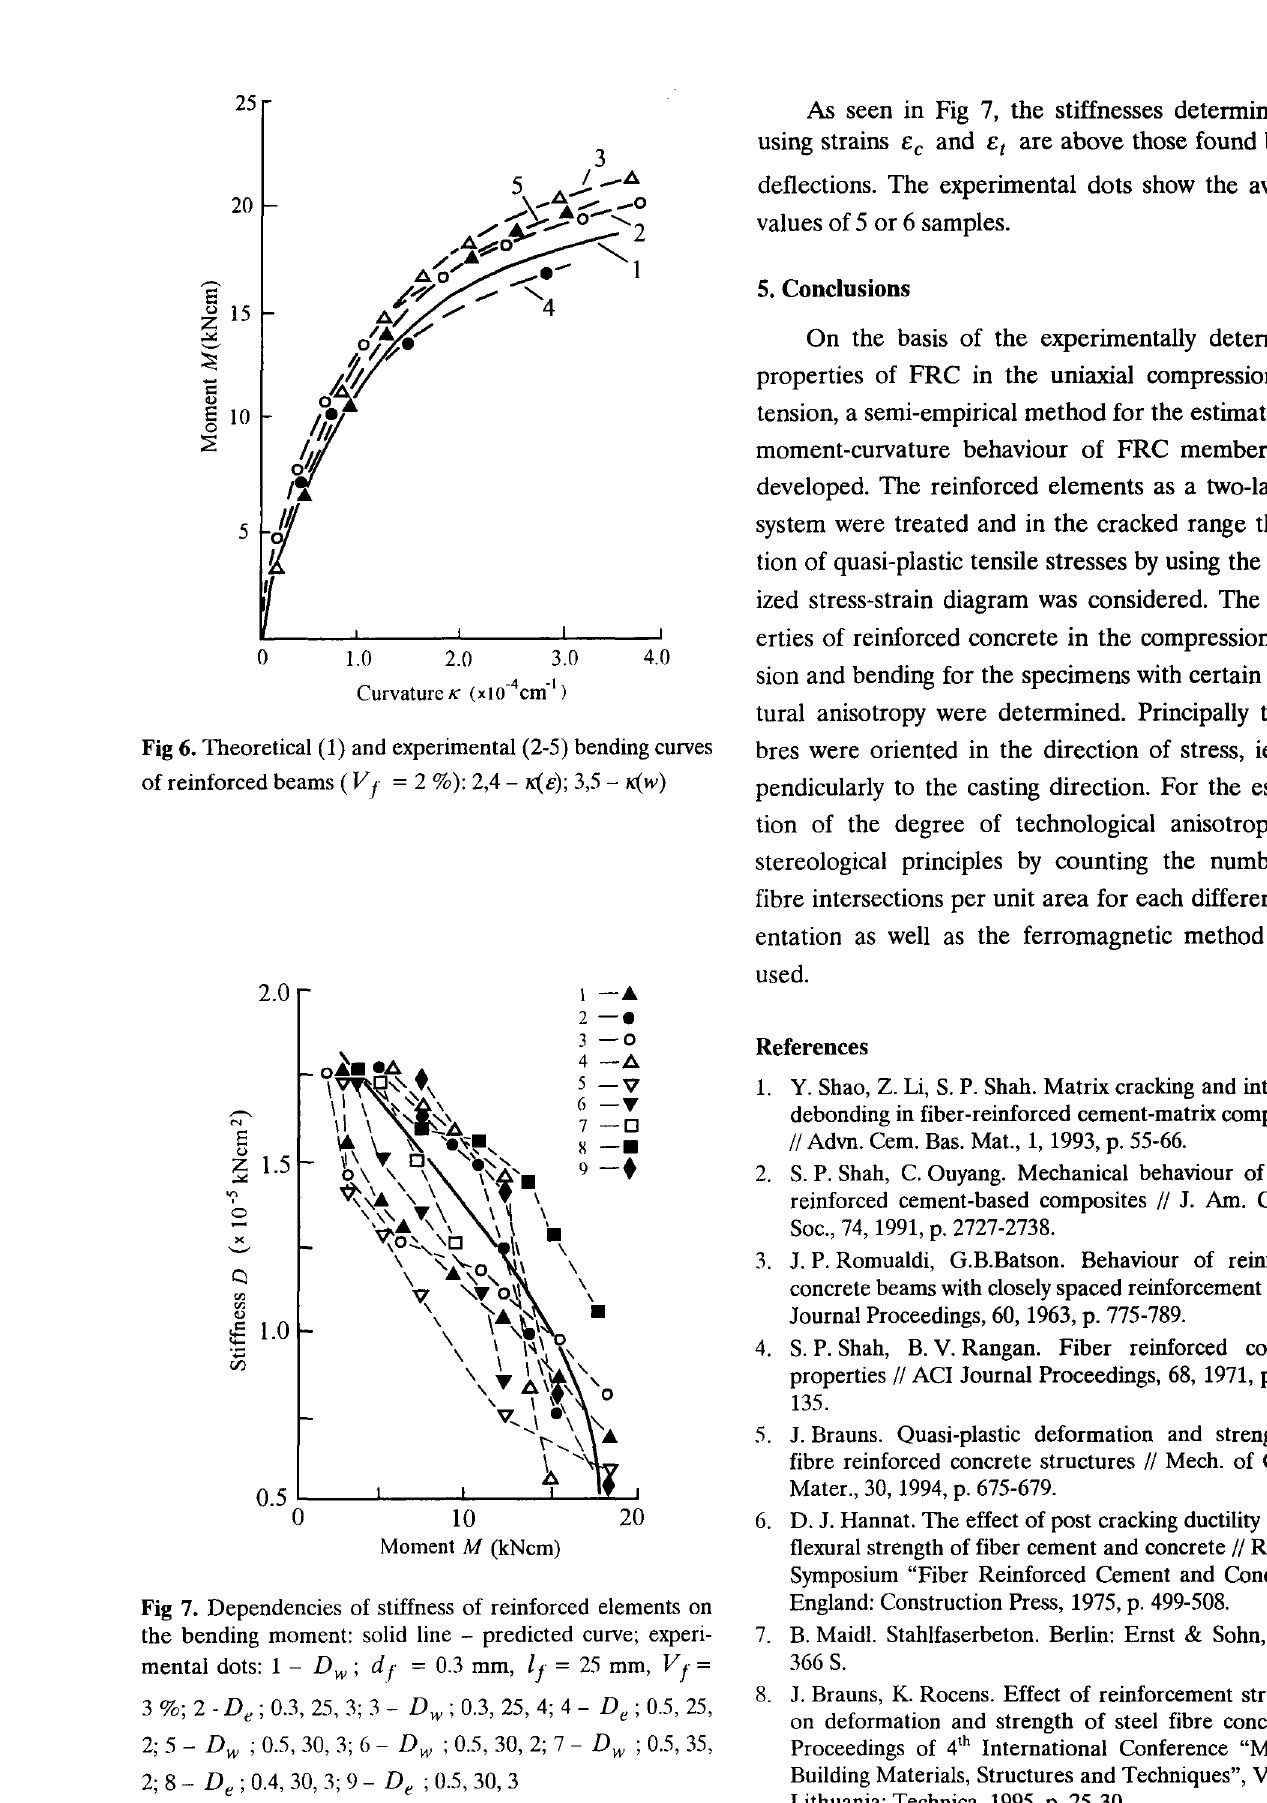
Fig 7. Dependencies of stiffness of reinforced elements on the bending moment: solid line - predicted curve; experi mental dots: 1- Dw; dr = 0.3 mm, If= 25 mm, Vf = 3 %; 2 -De; 0.3, 25, 3; 3- Dw; 0.3, 25, 4; 4- De; 0.5, 25, 2; 5- Dw ; 0.5, 30, 3; 6- Dw ; 0.5, 30, 2; 7- Dw ; 0.5, 35, 2;8- De;0.4,30,3;9- De